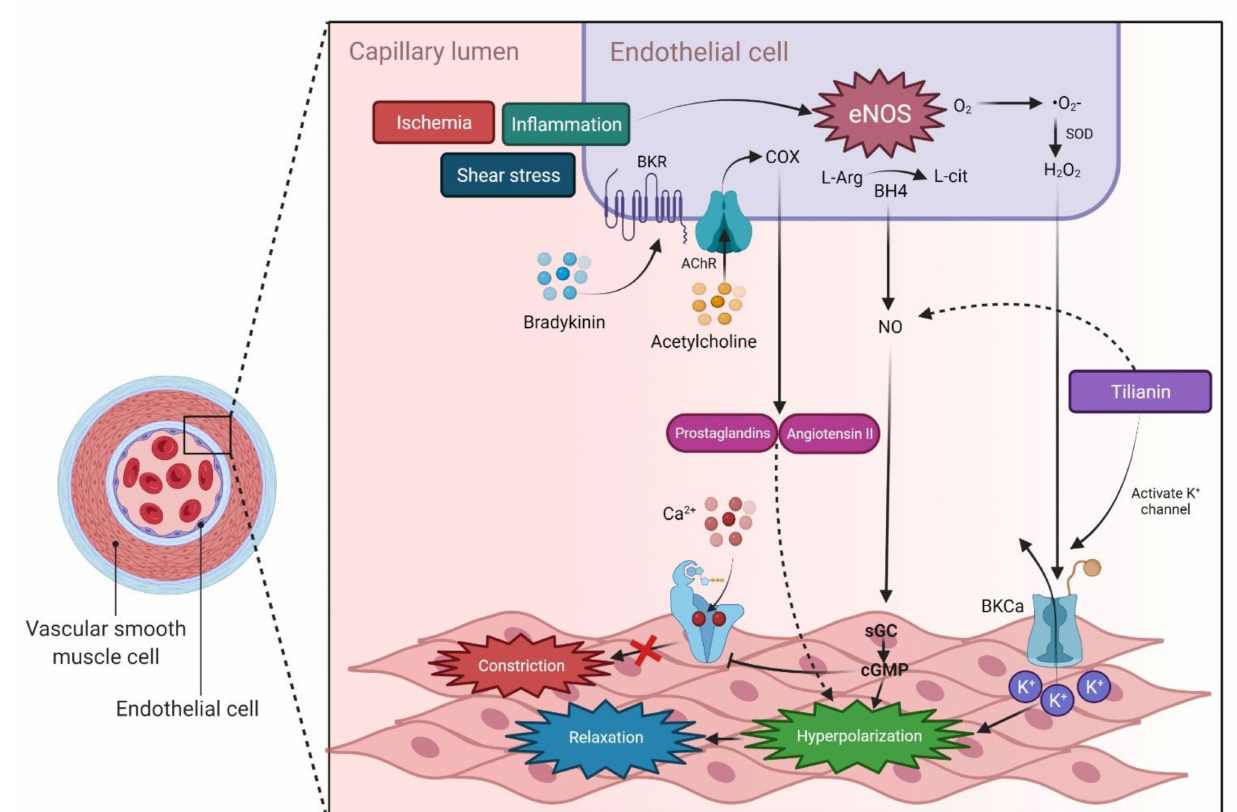
Figure 6. The endothelial cell is involved in a variety of physiological processes, including the regulation of VSMC via a balance of vasodilators and vasoconstrictors. After being activated by endogenous stimuli such as acetylcholine, bradykinin, inflammation, shear stress and ischemia, NO diffuses into smooth muscle cells and sGC to become cGMP, which promotes smooth muscle relaxation. Tilianin stimulates K + channels opening in vascular smooth muscle cells and NO release, resulting in hyperpolarization of the cell membrane and tissue relaxation [34]. Abbreviations: VSMC, Vascular smooth muscle cell; eNOS, Endothelial nitric oxide synthase; COX, Cyclooxygenase; SOD, Superoxide dismutases; O 2 , Oxygen; • O2 − , superoxide; H 2 O 2 , Hydrogen peroxide; L-Arg, L-arginine; BH4, Tetrahydrobiopterin; L-cit, L-citrulline; AChR, Acetylcholine receptor; BKR, Bradykinin receptor; NO, Nitric oxide; BKCa, Ca 2+ -activated K + channel; sGC, Soluble guanylate cyclase; cGMP, Cyclic guanosine monophosphate; K + ,